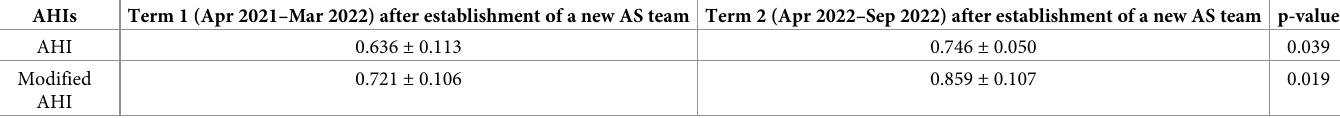
Table 5. Antibiotic heterogeneity indices (AHIs) in term 1 and term 2 after the establishment of a new antibiotic stewardship team in the community hospital.